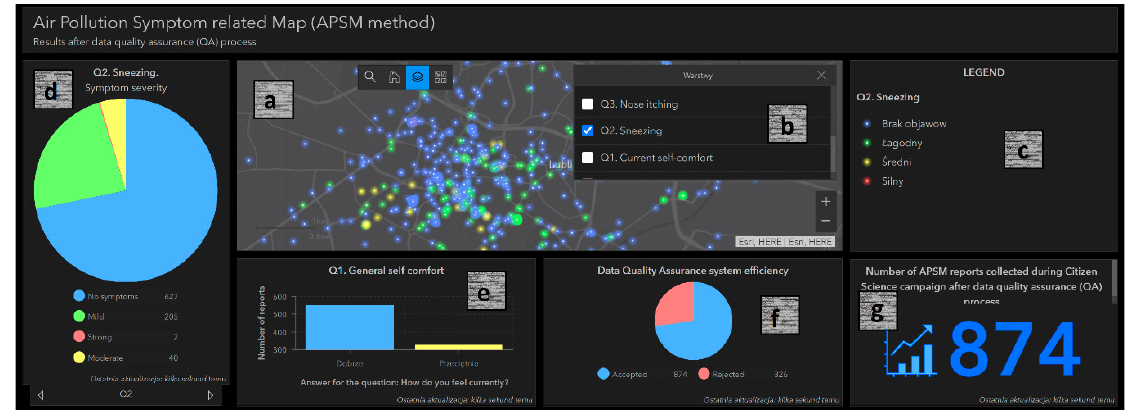
Figure A5. Web mapping application operations dashboard, presenting results of QA s8 -checked data: ( a ) map, ( b ) selectable layer list, ( c ) legend, ( d ) pie chart presenting severity of each air pollution related symptom, ( e ) bar chart of citizen general comfort, ( f ) pie chart of QA system robustness, and ( g ) indicator of QA-checked reports changing according to the map extent.